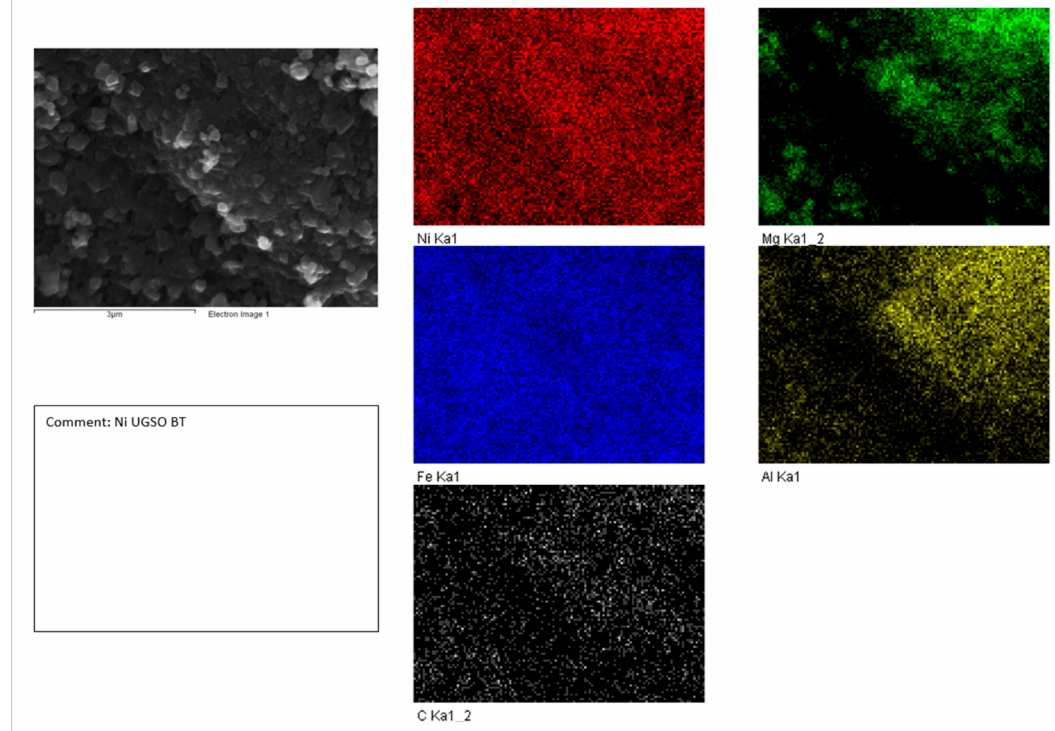
Figure 9. Mapping analysis of Ni-UGSO